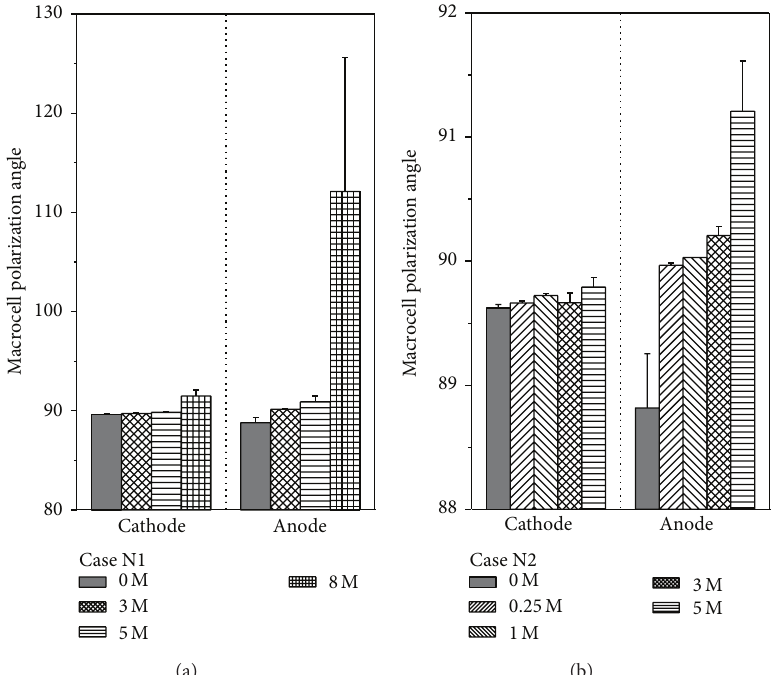
Figure 10: Effect of nitrite concentrations on the macrocell polarization angles of cathode and anode. (a) Case N1, (b) Case N2.